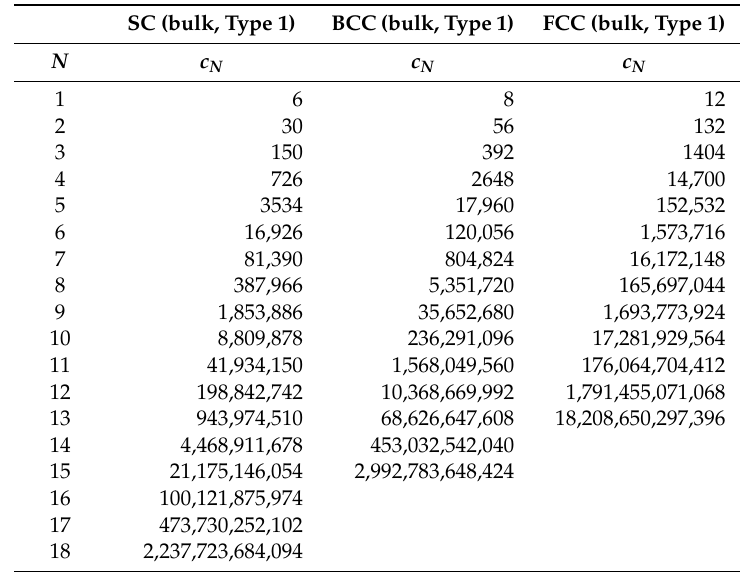
Table A2. Number of distinct configurations of SAWs on 3-D regular lattices without spatial restrictions (bulk case): simple cubic (SC), body center cubic (BCC) and face center cubic (FCC). Due to symmetry all nodes correspond to a single SAW origin (Type 1).